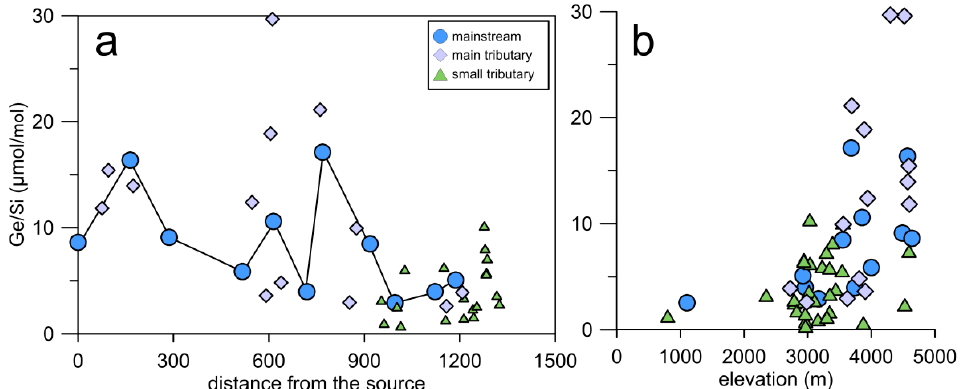
Figure 4. Spatial variations in Ge/Si ratio of the Yarlung Tsangpo River. ( a ) Relations between Ge/Si ratio and distance from the source; ( b ) Relations between Ge/Si ratio and elevation.